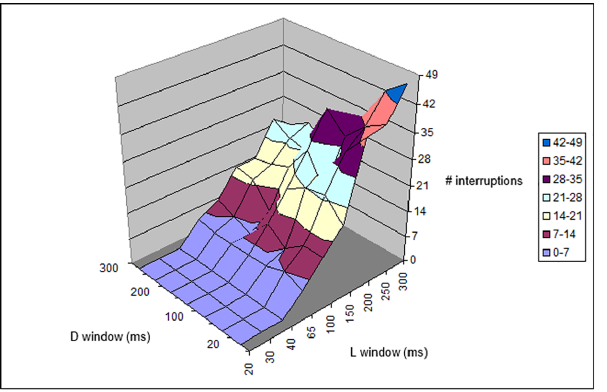
Fig 10. Plot of data given in Table 2. Number of interruptions with respect to L window and D window lengths, for a 5,000-ms period at 500 photons/s and a threshold of 8, as reported in Table 2.